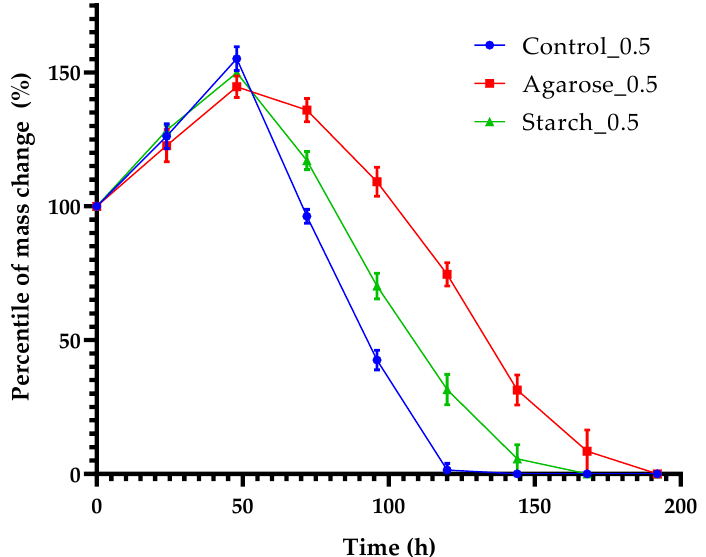
Figure 12. Percentile of mass change in time.